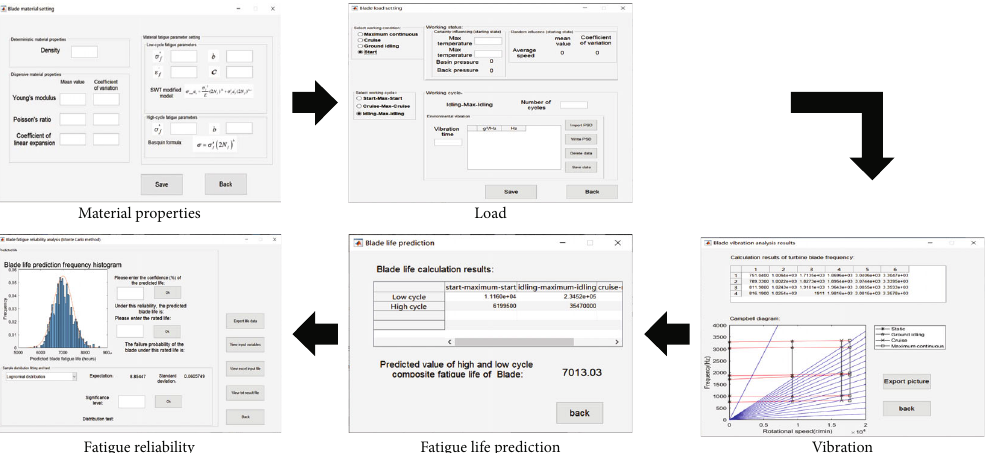
Figure 18: The analysis process for turbine blade.